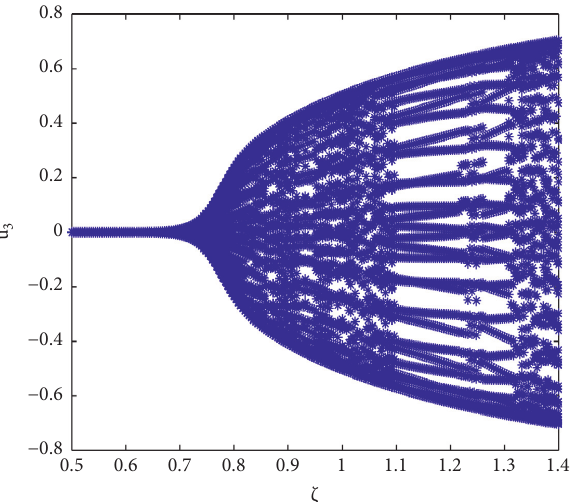
Figure 5: Bifurcation figure of neural network model (4.2): ζ - u . 1